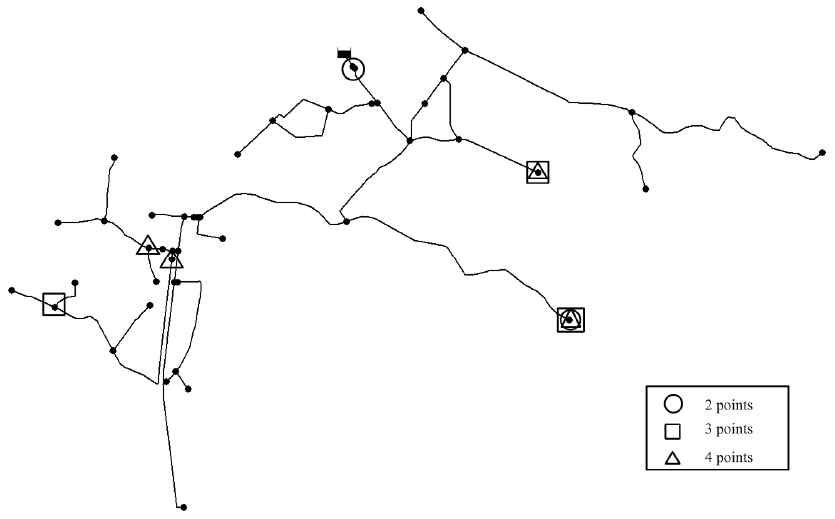
Figure 10. Locations of re-chlorination points for each scenario (network 2).